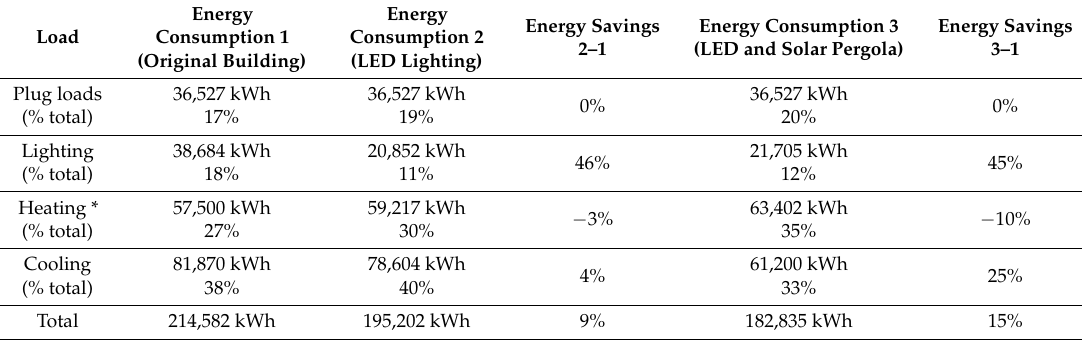
Table 5. Energy consumption of the original/refurbished building models and energy savings.